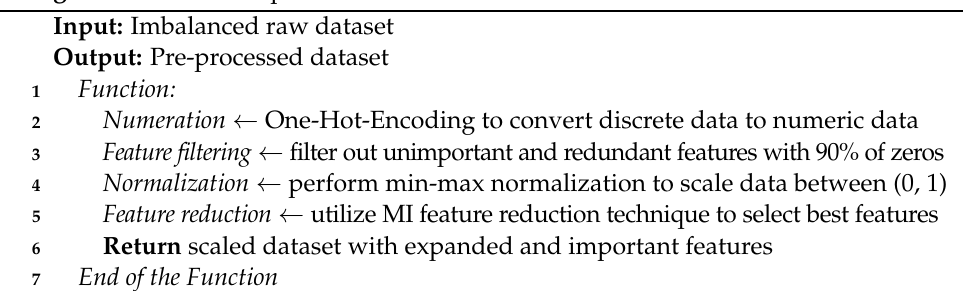
Algorithm 1: Data Preparation.